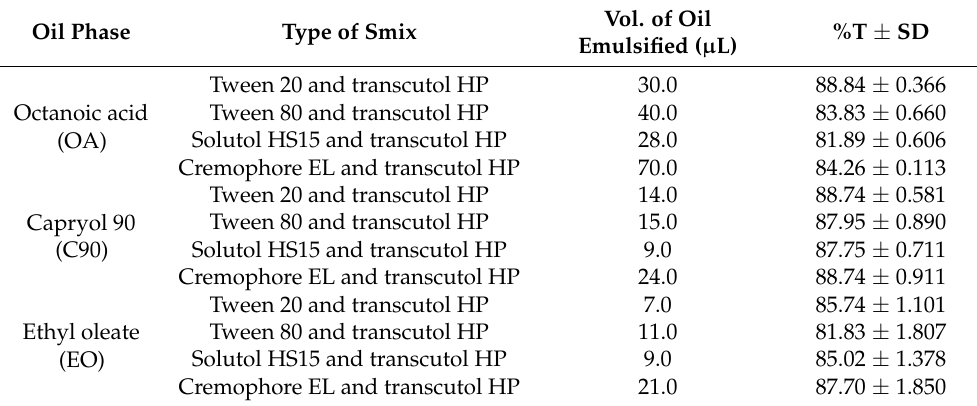
Table 1. Volume of oil (OA, C90, and EO) emulsified and % transmittance (%T) of dispersion system consisting of oil emulsified in 10% aqueous Smix (1:1)